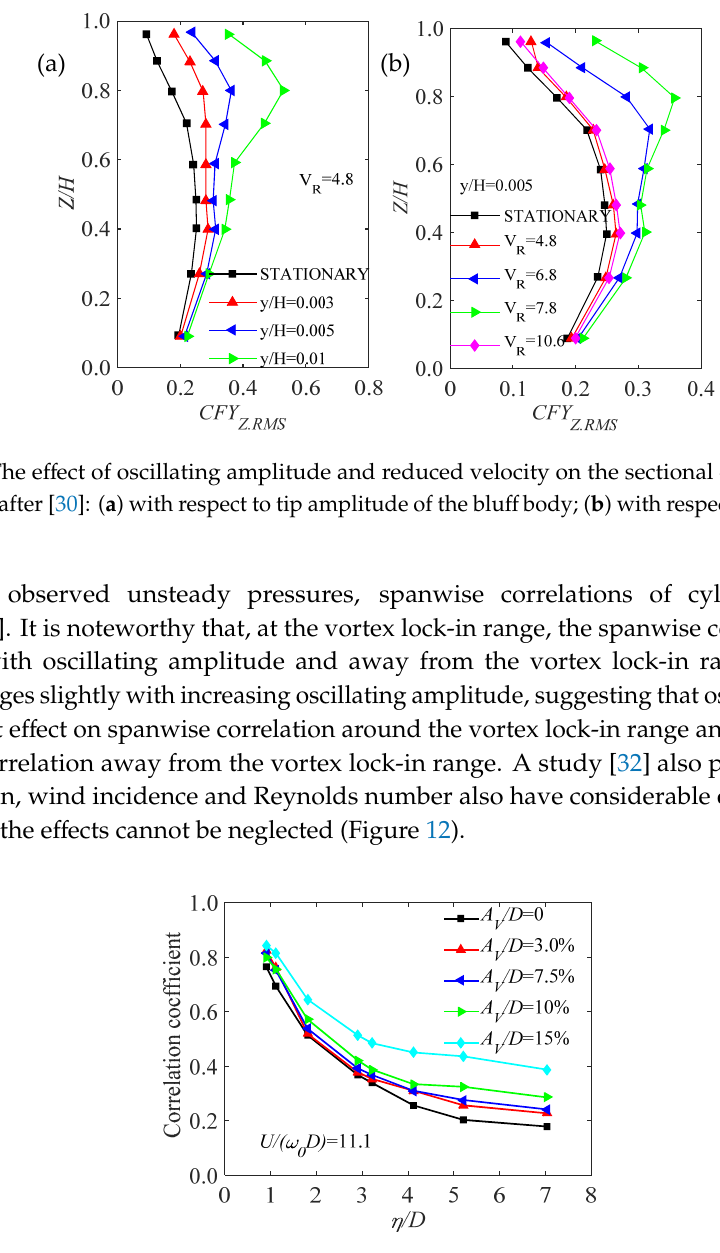
Figure 12. Effect of the vertical amplitude on the spanwise correlation of aerodynamic forces acting on an oscillatory cylinder around the vortex lock-in range [32].